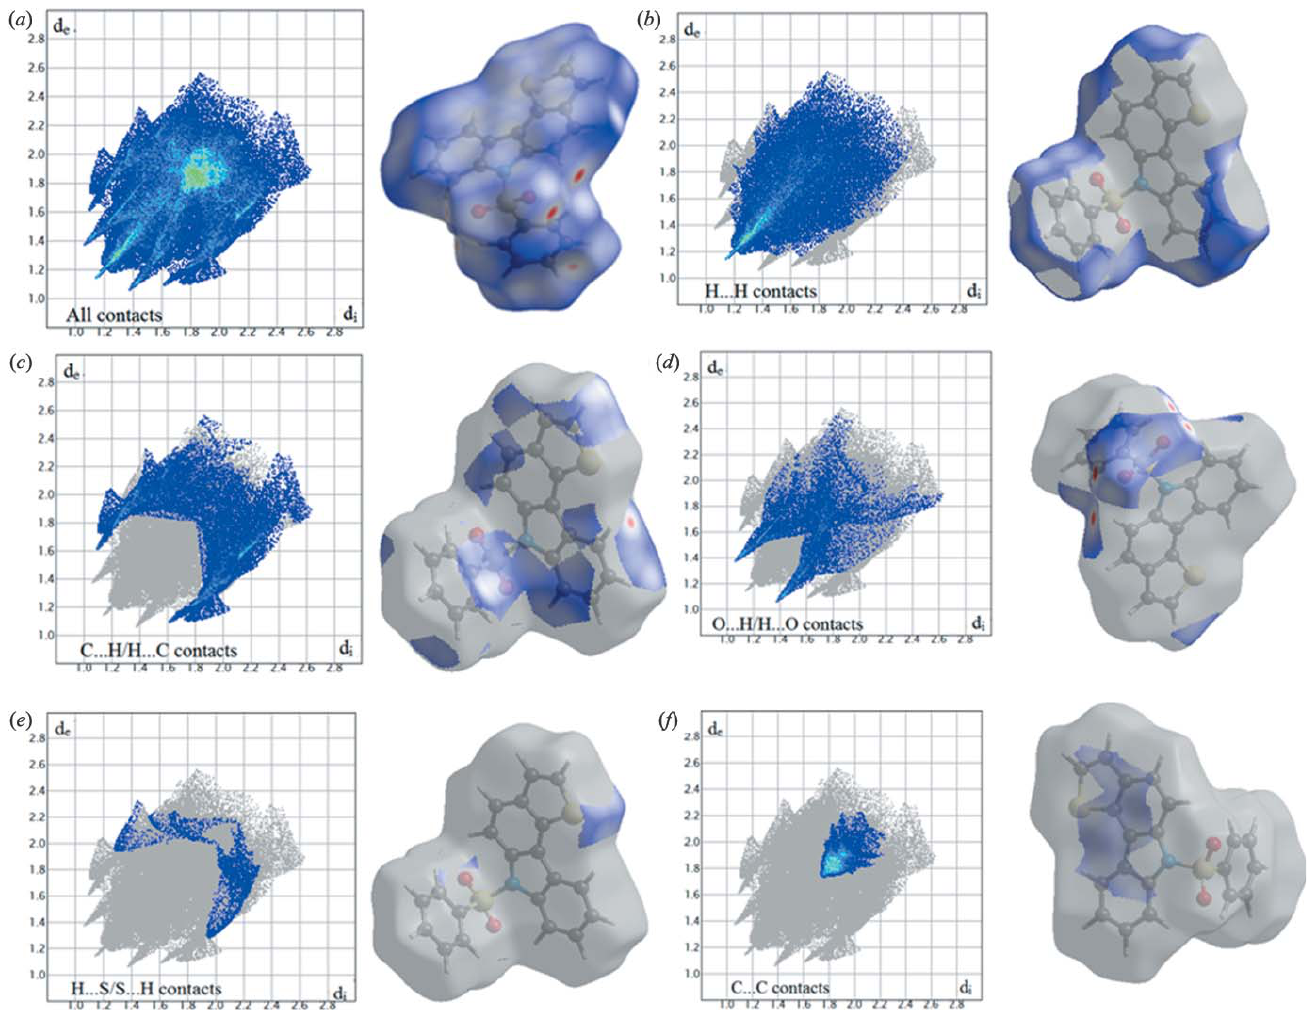
Figure 4 Two-dimensional fingerprint plots for the title compound showing the contributions of different types of interactions: ( a ) all intermolecular contacts, ( b ) H (cid:3)(cid:3)(cid:3) H contacts, ( c ) C (cid:3)(cid:3)(cid:3) H/H (cid:3)(cid:3)(cid:3) C contacts, ( d ) O (cid:3)(cid:3)(cid:3) H/H (cid:3)(cid:3)(cid:3) O contacts, ( e ) H (cid:3)(cid:3)(cid:3) S/S (cid:3)(cid:3)(cid:3) H contacts and ( f ) C (cid:3)(cid:3)(cid:3) C contacts. The outline of the the full fingerprint is shown in gray. Surfaces to the right highlight the relevant surface patches associated with the specific contact type and are coloured as d norm .